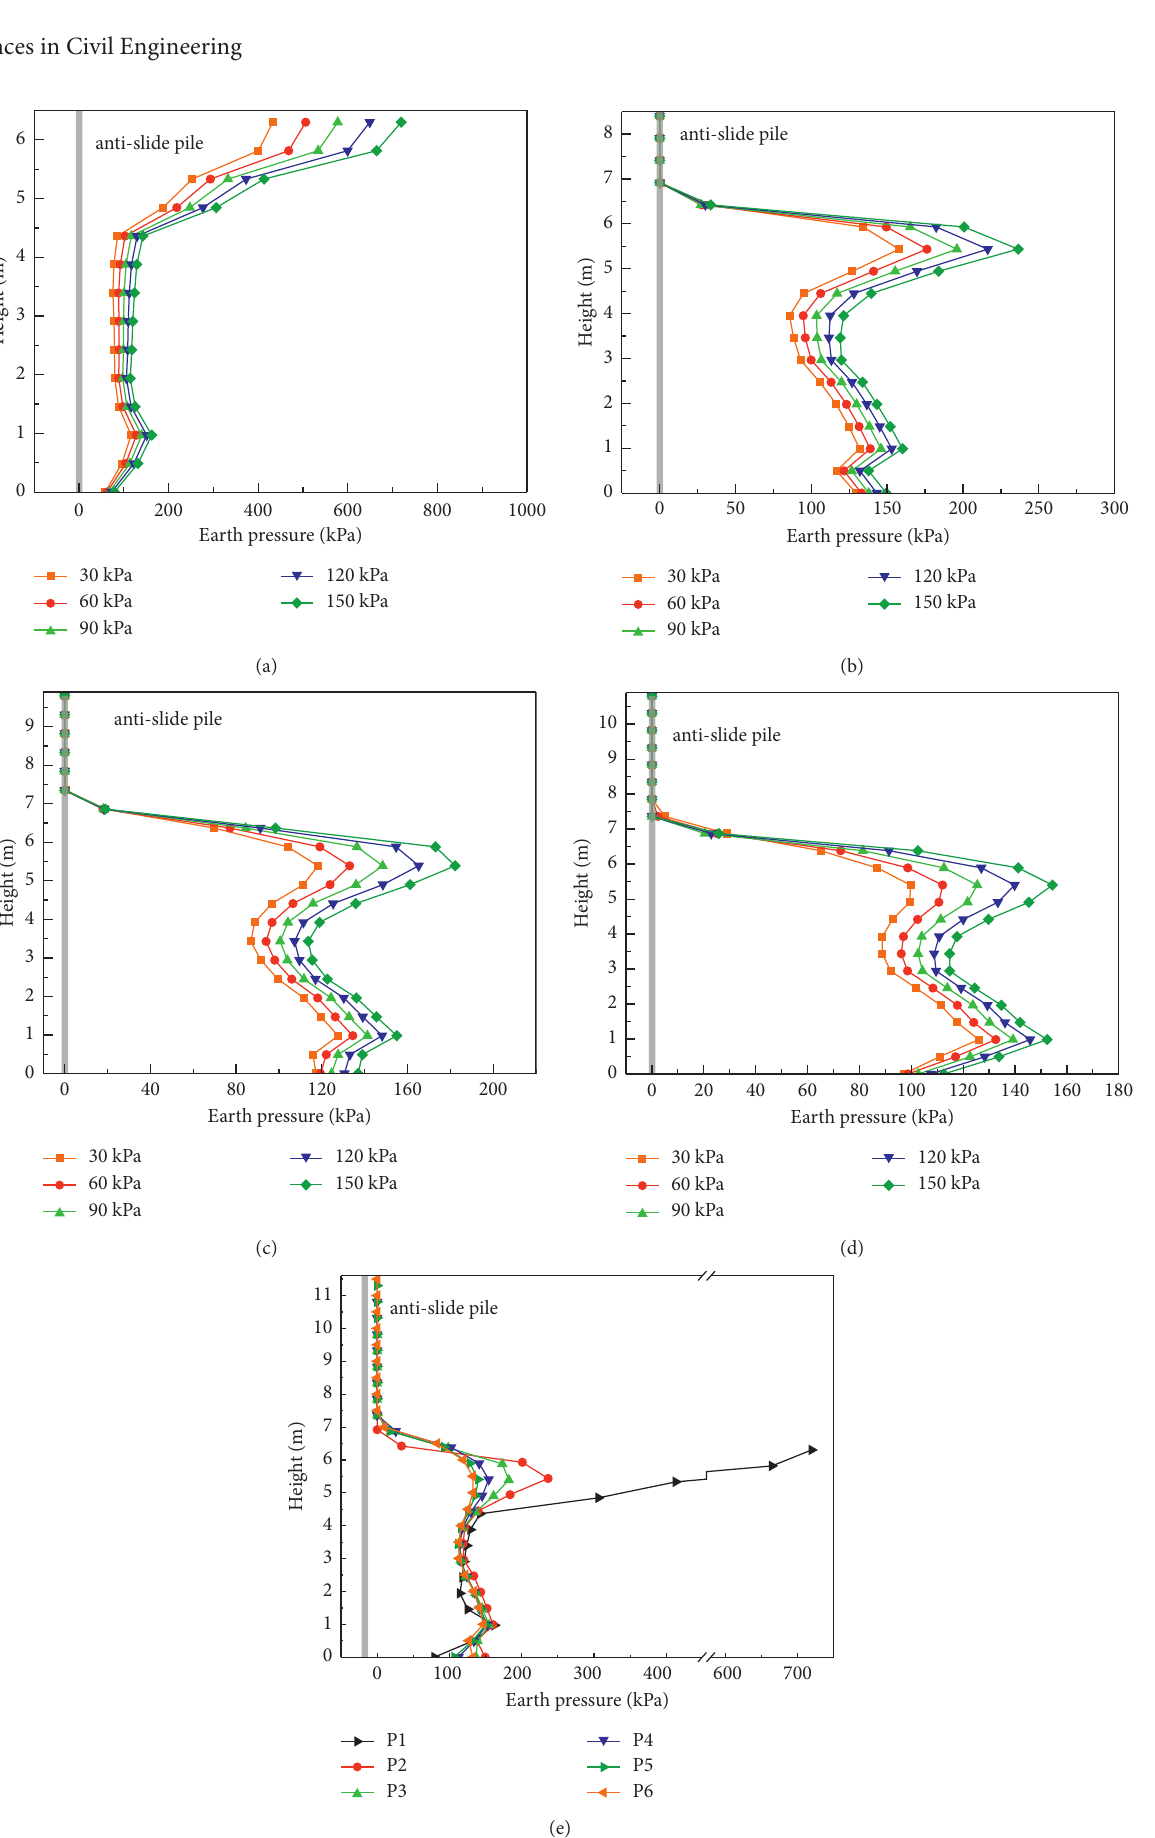
Figure 13: Earth pressure in front of pile (3-16): (a) P1; (b) P3; (c) P5; (d) P6; (e)